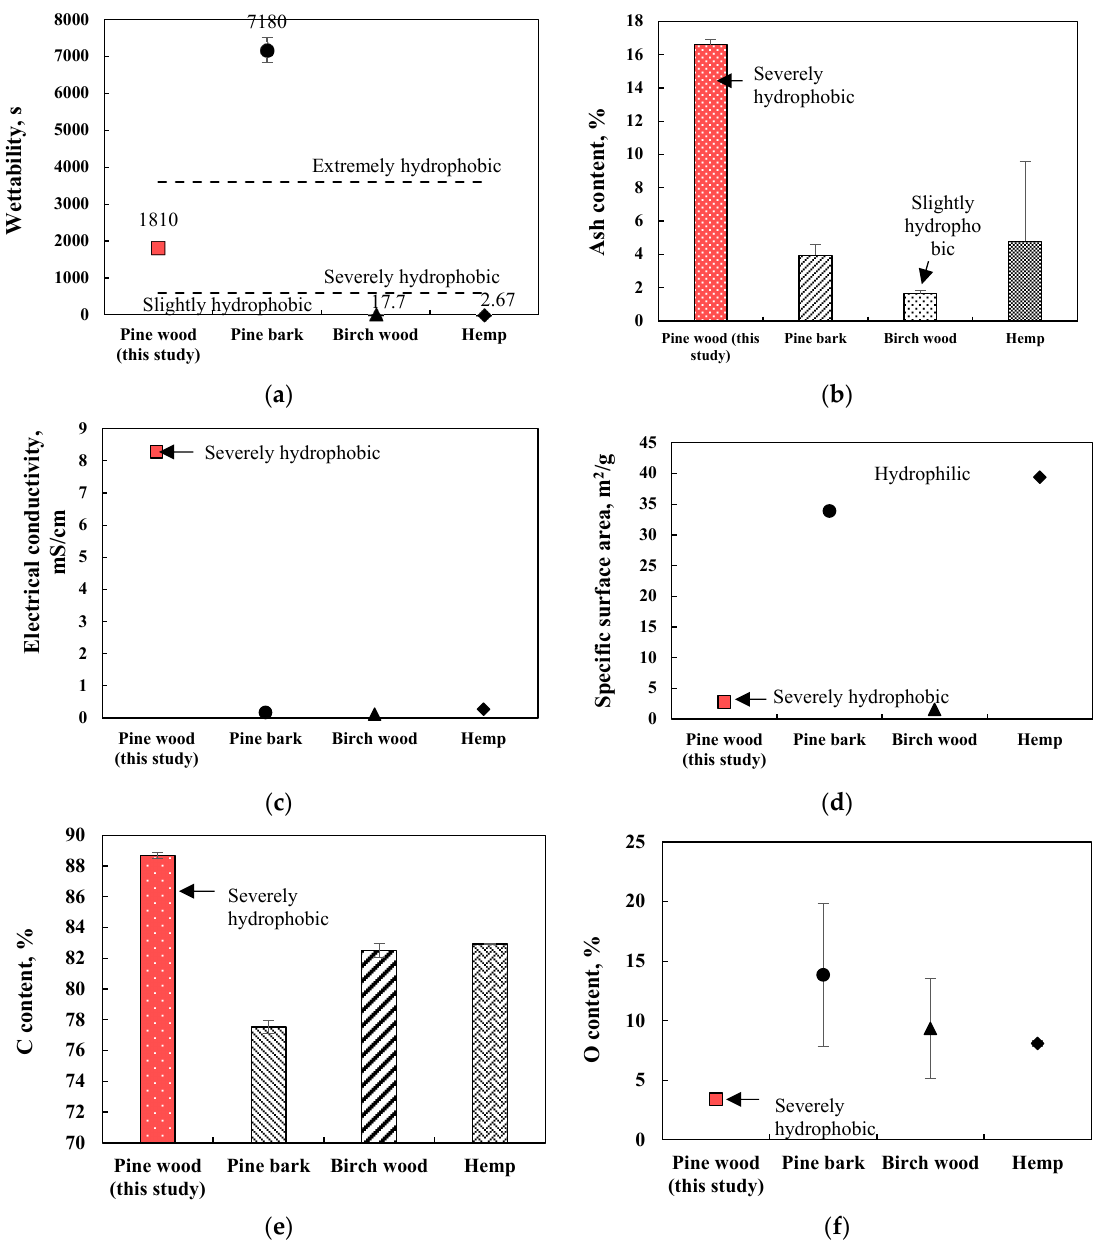
Figure 2. The comparison of physical-chemical properties of different biochar types, made from pine wood, birch wood, pine bark and hemp (450 °C, 2 h): ( a ) wettability (s), ( b ) ash content (%), ( c ) electrical conductivity (mS/cm), ( d ) specific surface area (m 2 /g), ( e ) C content (%), ( f ) O content (%), n = 3. Table 1. Physical-chemical properties of low-temperature pine wood biochar, n = 3, ± standard deviation.